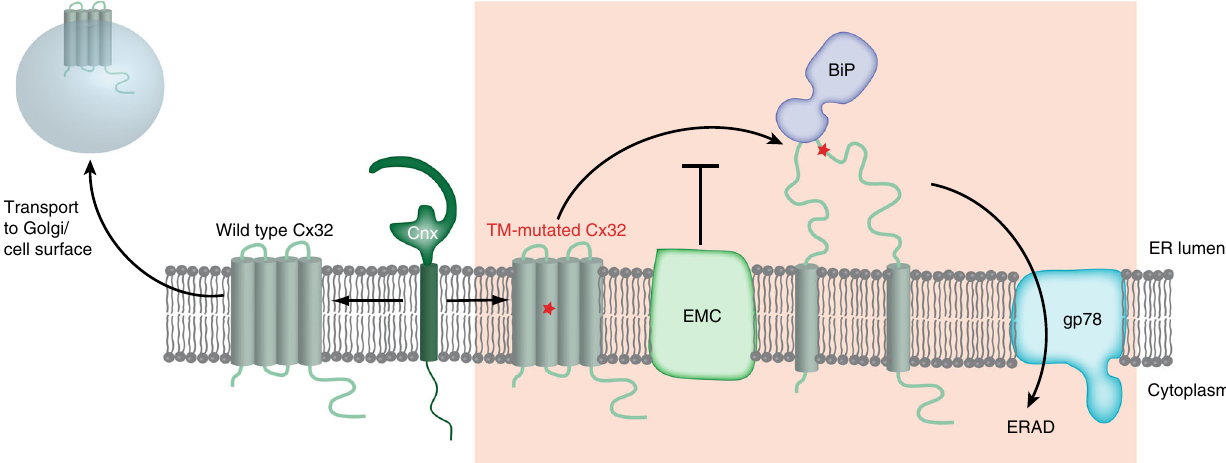
Fig. 5 A model for the biogenesis and quality control of multipass TM proteins. A red asterisk indicates a mutation that leads to membrane misintegration for Cx32. Chaperones and quality control factors identi fi ed in this study to act on Cx32 are